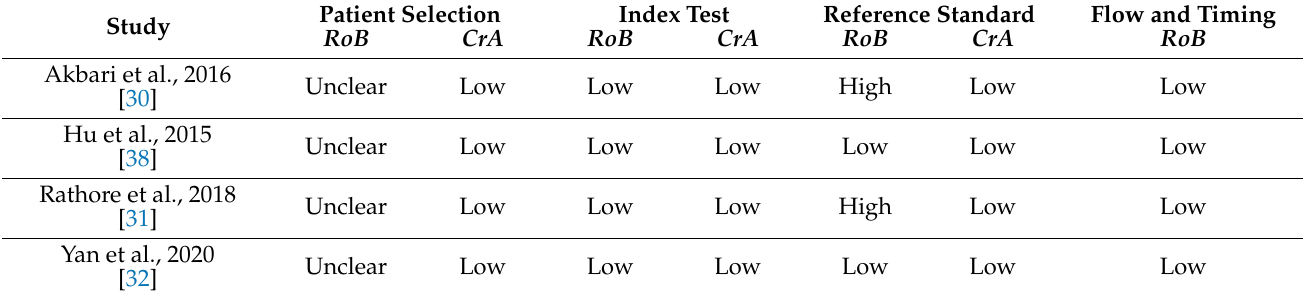
Table 2. QUADAS2. Diagnostic accuracy test on separate validation cohort.